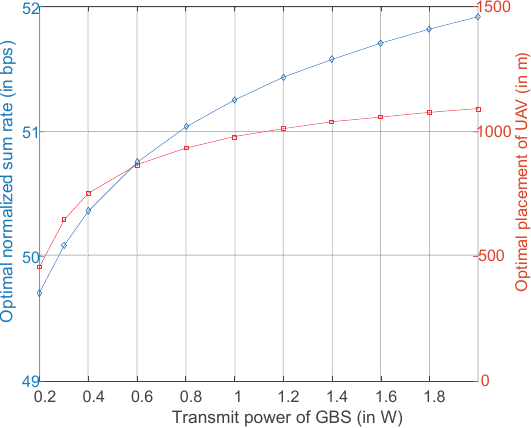
Figure 5. Optimal normalized sum-rate and optimal UAV’s projection distance versus GBS transmit power.